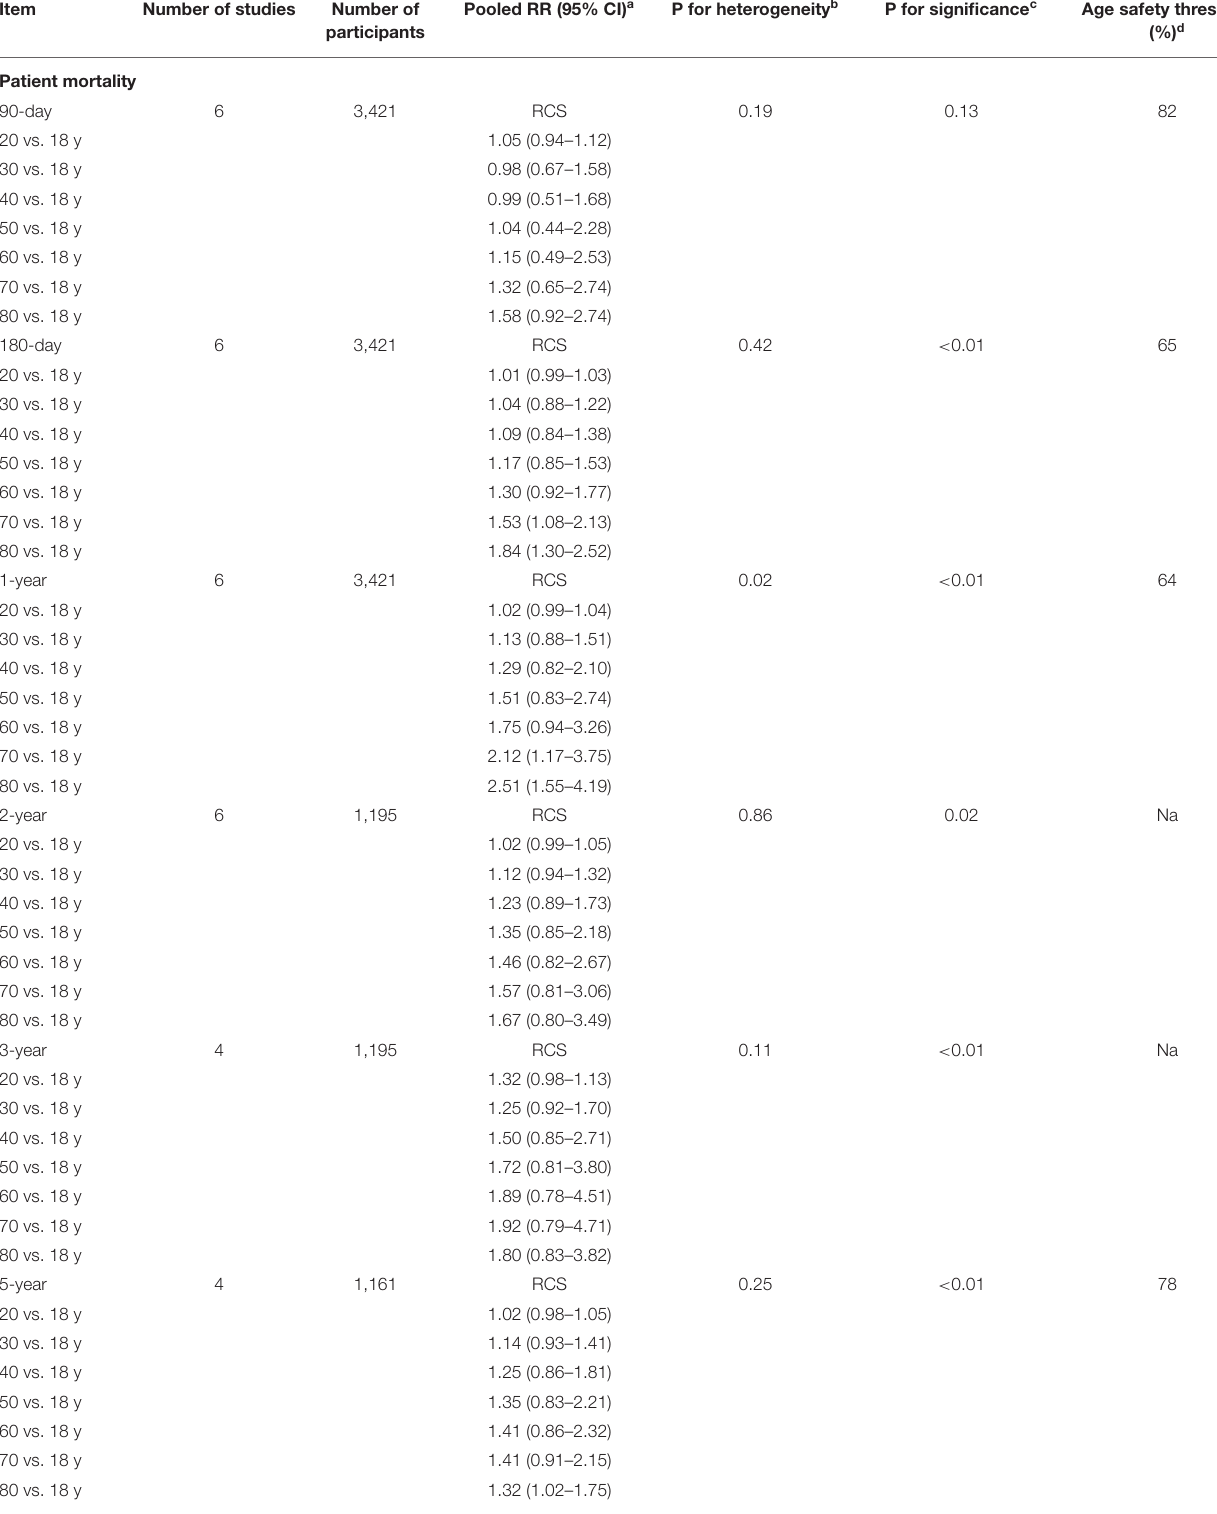
TABLE 4 | Risk of donor age on post-operational outcomes in different time points by non-linear